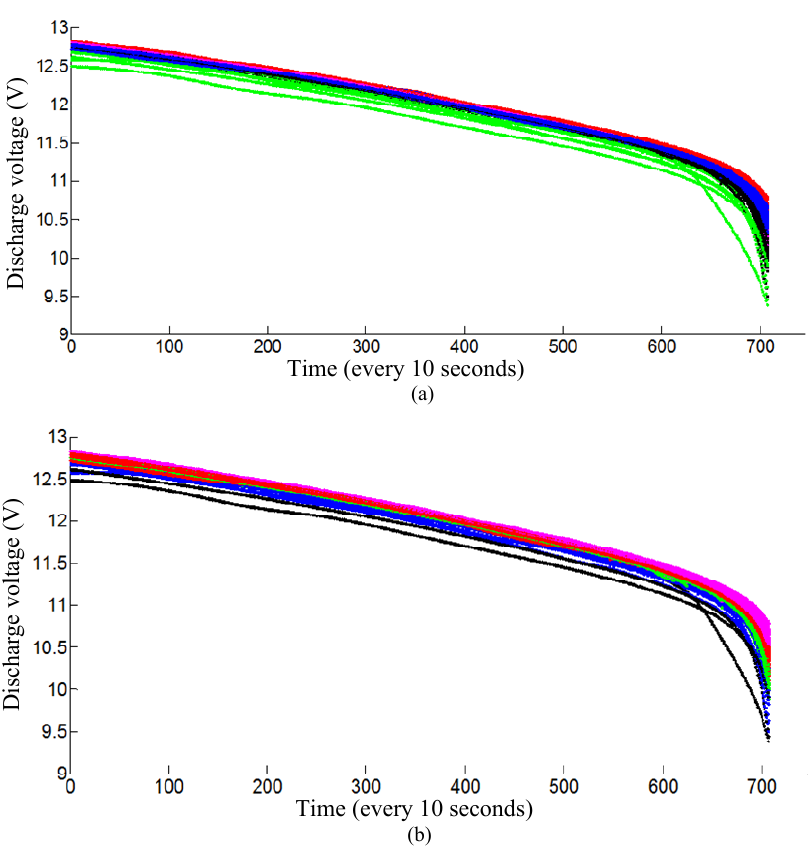
Figure 4. Grouping results of a shelf using different clustering algorithms: ( a ) Results of the k-means algorithm [16]; ( b ) Results of spectral clustering algorithm [21,24]. Note that the battery discharge curves can be divided into several clusters (represented by different colors), but it is impossible to decide which m batteries should be grouped into the same